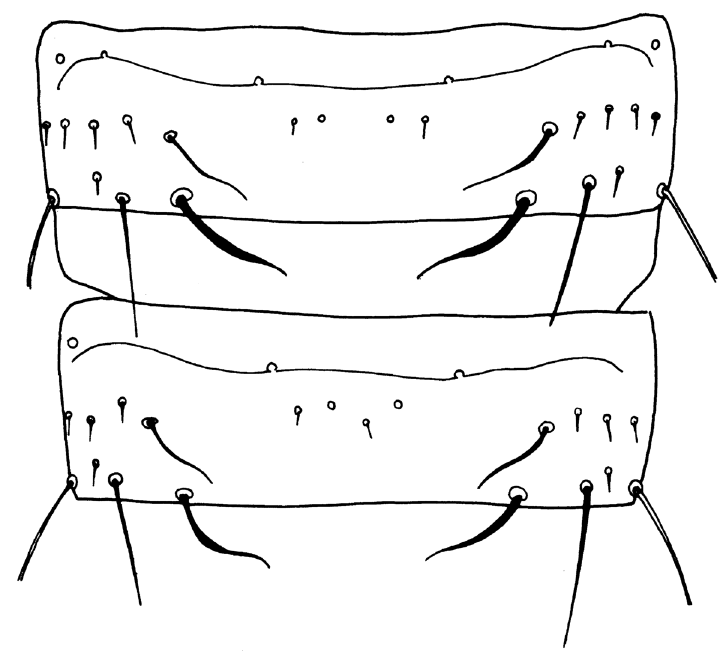
Figures 8. Haplothrips shivendraii sp. n.: Tergites IV–V,